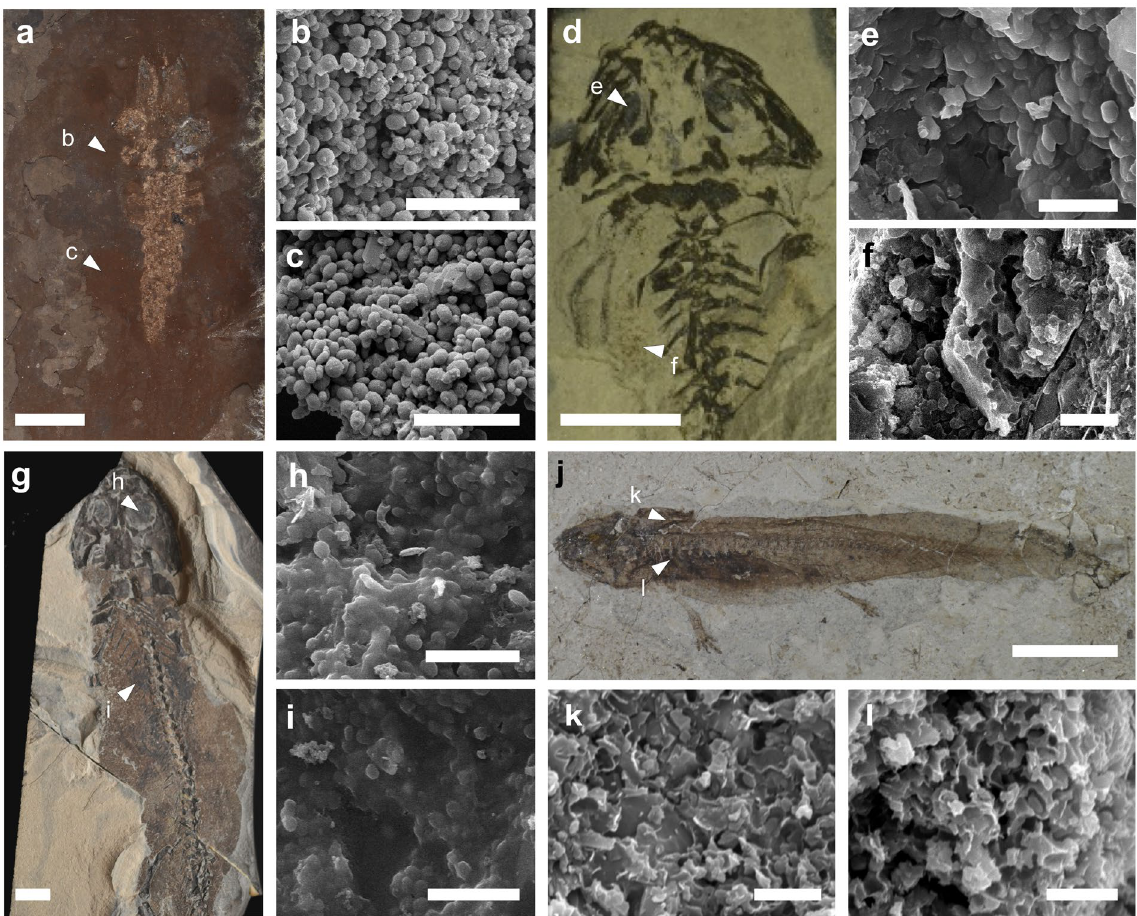
Figure 1. Fossil vertebrates and preserved melanosomes. ( a , d , g , j ) Fossil specimens presenting dark organic rich films. Scale bars 10 mm. ( a ) P. diluvianus (NHML-30271); ( d ) B. amplystomus (NHMD-155208); ( g ) M. credneri (NHMB-MB-Am.-1187); ( j ) Amphibia indet. (CNU-SAL-NN2013002P). White triangles denote sampling points. ( b , c , e , f , h , i , k , l ) Scanning electron micrographs of preserved melanosomes in soft tissue samples. Scale bars: b , c , e , f , g , i , 5 µ m; k and l , 2 µ